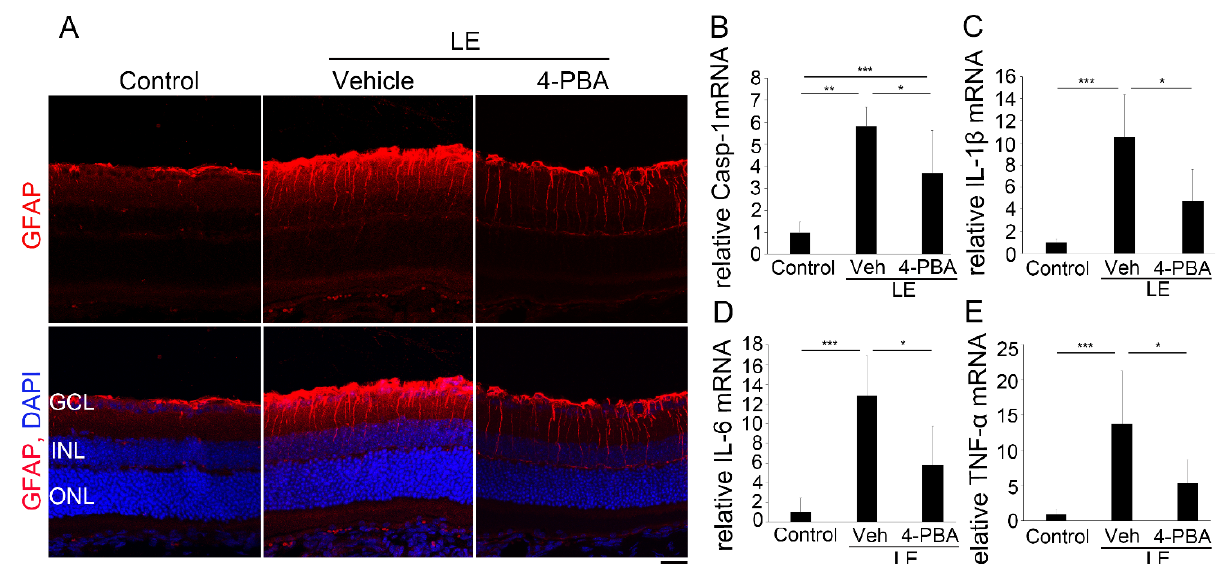
Figure 5. 4-PBA suppressed neuroinflammation. ( A ) Immunohistochemistry for GFAP (red) 24 h after light exposure. Light-induced increase in GFAP expression was attenuated by 4-PBA administration. DAPI staining (blue). ( B – E ) mRNA levels of pro-inflammatory molecules using real-time transcription polymerase chain reaction at 24 h after LE. ( B ) The Caspase-1, ( C ) IL-1 β , ( D ) IL-6, and ( E ) TNF- α mRNAs were upregulated after LE; however, the levels were attenuated in the LE-treated-with-4-PBA group. LE, light exposure; Veh, vehicle. ( B – E ) Data are presented as mean ± standard deviation. A statistically significant difference between Control and LE-with-4-PBA-treatment groups was only found in caspase-1 mRNA levels. ( A ) n = 4 in each group; ( B – E ) n = 5–6. Scale bar, 50 μ m. * p < 0.05, ** p < 0.01, *** p < 0.001. ANOVA with Tukey post-hoc tests.